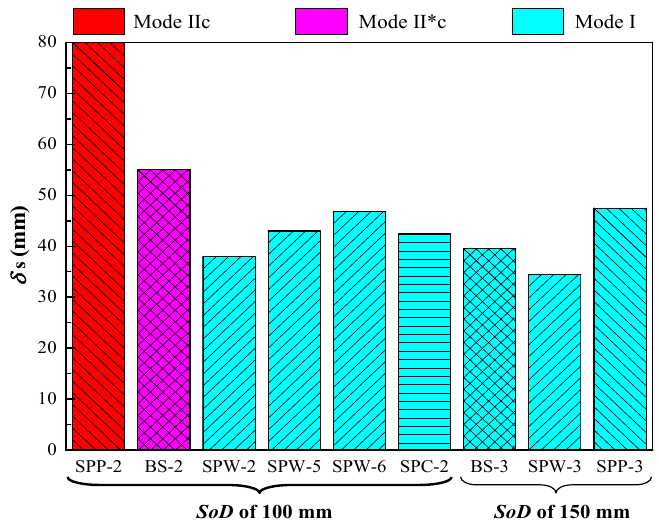
Figure 9. Influence of spraying strategy on the performance of polyurea-coated steel plates under air blasts.